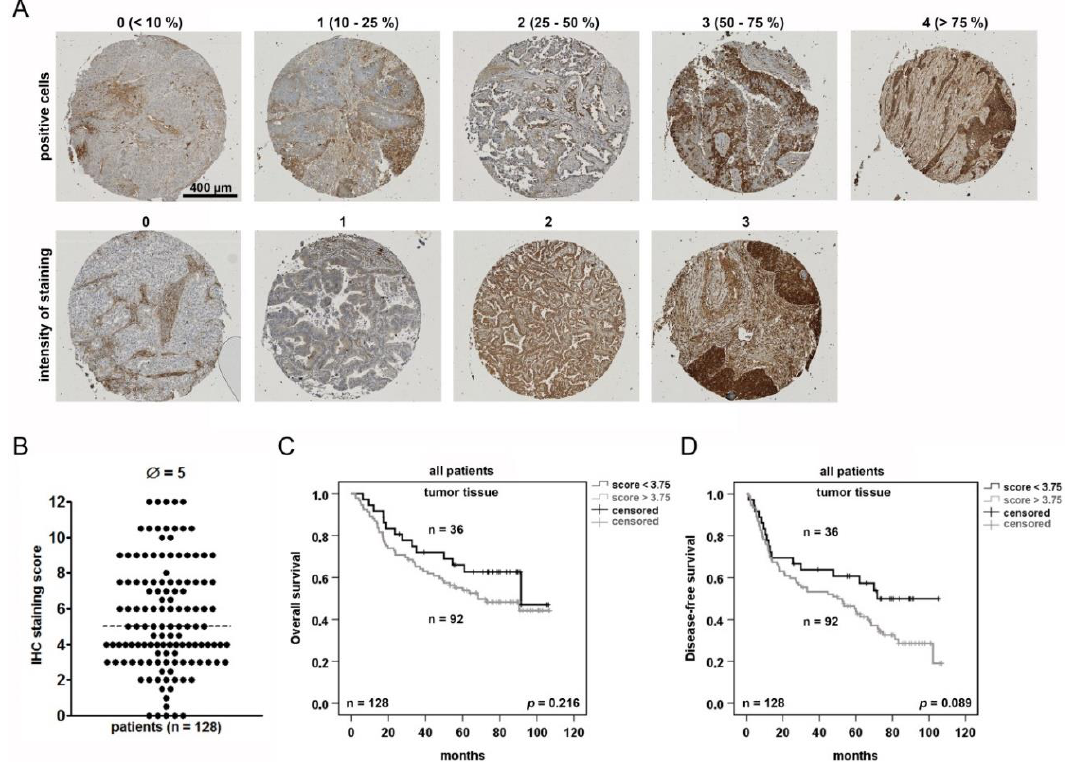
Figure 2. Tumor cells positive for AAT are prognostic indicator for the patient’s disease-free survival. ( A ) Scoring of NSCLC according to a positive AAT staining. Tissue micro array (TMA) with two cores for each sample was stained for AAT. ( B ) Immunohistochemistry (IHC) score generated from multiplication of intensity of staining and positivity for AAT protein. ( C ) and ( D ) Kaplan-Meier overall and disease-free survival curves using the staining score of 3.75 as cut-off to separate the two groups. p < 0.05 was considered significant.